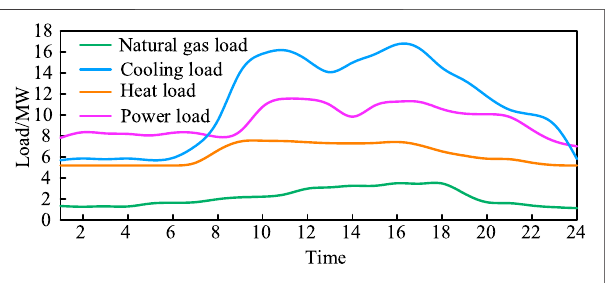
FIGURE 6 | The comparison of the power subsystem.